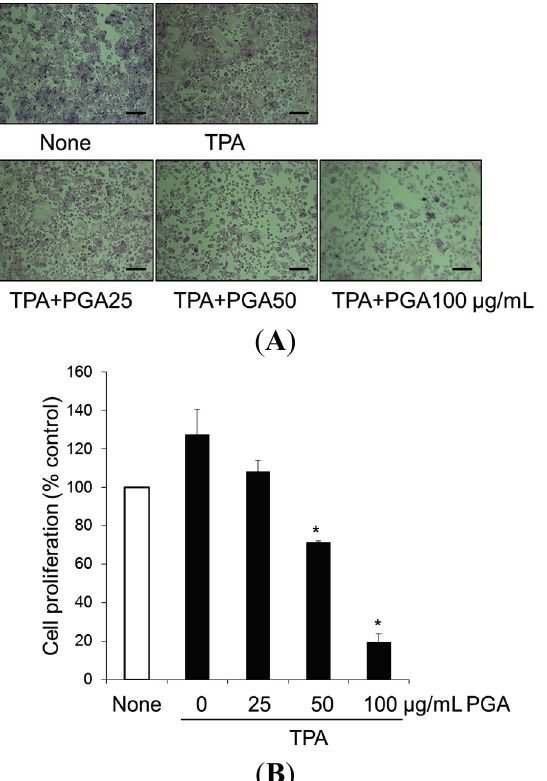
Figure 1. Effect of poly- γ -glutamic acid (PGA) on TPA-induced proliferation in HT-29 human colorectal cancer cells. Cells were treated with 100 nM 12- O -tetradecanoylphorbol- 13-acetate (TPA), alone or in combination with PGA, at 25, 50, 100 μ g/mL for 48 h, and then morphological changes of HT-29 cells were observed under phase-contrast microscope ( A ). Scale bar = 20 µm; Under same condition, cell proliferation was measured using the (4,5-dimethylthiazol-2-yl)-2,5 diphenyltetrazolium bromide (MTT) assay ( B ). Data representative of three independent experiments and were expressed as mean ± SD. * p < 0.05 vs. TPA